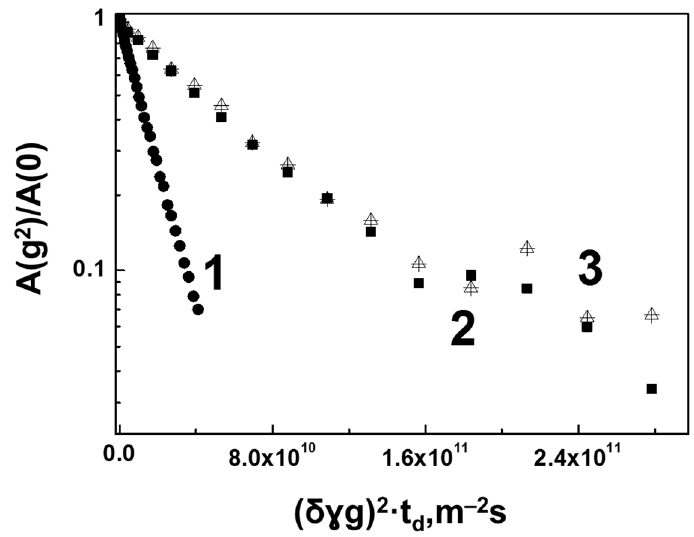
Figure 10. Diffusion decay of the spin echo signal for lysozyme molecules obtained with a diffusion time of 50 ms. Curve 1— lysozyme in aqueous solution at a protein concentration of 0.2%; Curve 2—lysozyme in an aqueous solution of a mixture of lysozyme and HA at concentrations of 0.2% and 0.75% (mass), respectively (obtained by integrating signals in the region of 6.5–8 ppm in the proton spectrum (Figure 7); Curve 3—normalized per unit diffusion decay obtained by subtracting the contribution of molecules with an SDC equal to 1.6 × 10 − 13 m 2 /s from the SDC values for lysozyme and HA aqueous solution at concentrations of 0.2% and 0.75% (weight), respectively, shown in Fig- ure 8. At the indicated integration range (from 1.6 to 3.0 ppm), this di ff usion decay mostly refers to the HA.